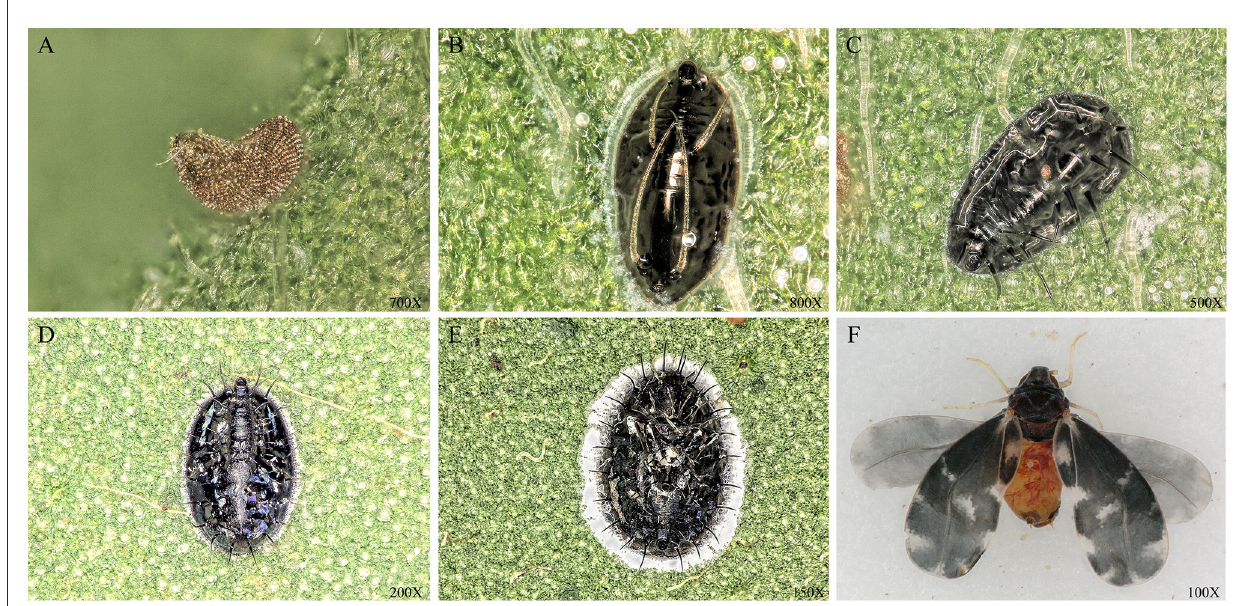
FIGURE1 Morphology of A. camelliae at different stages. (A) egg; (B) the first instar nymph; (C) the second instar nymph; (D) the third instar nymph; (E) Pupa; and (F) Adult. The picture was taken under the Ultra-Depth Microscope (Leica DVM5, Germany).